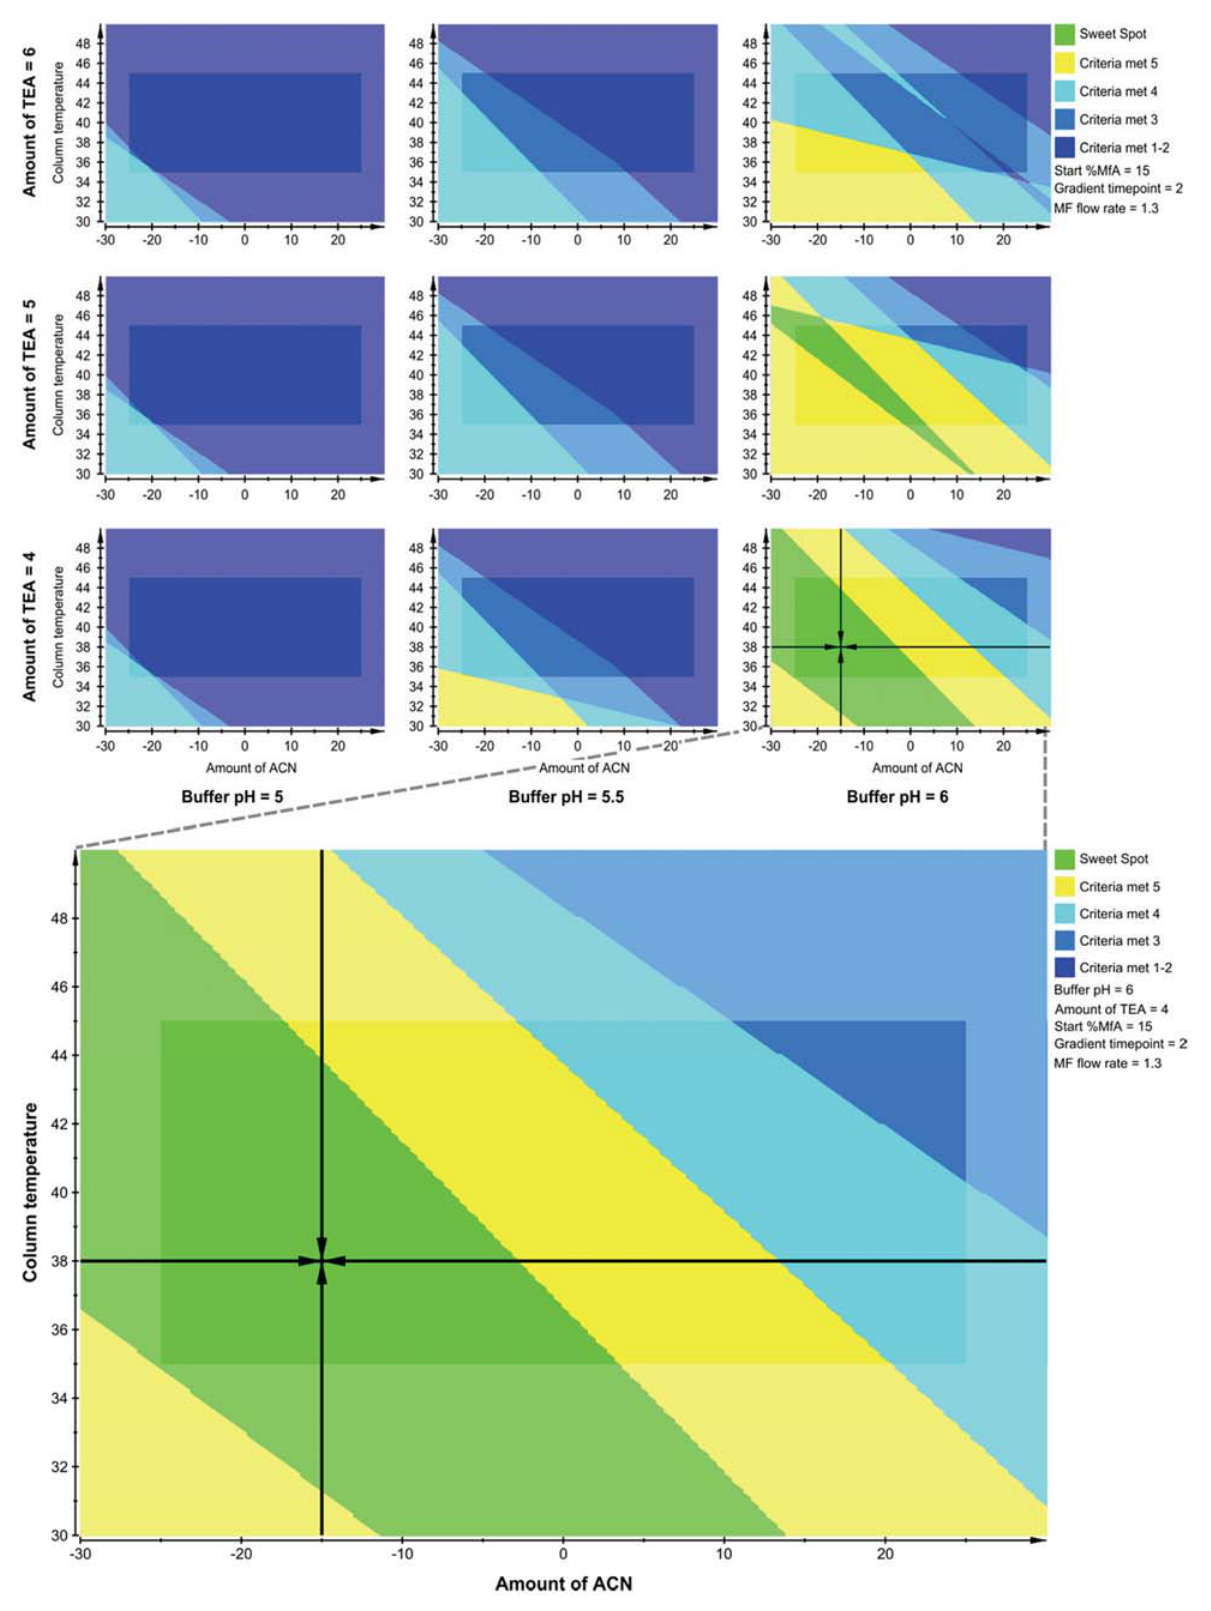
Figure 3. Sweet spot diagram for a PLS model of the analytical operational design region. The optimal chromatographic conditions proposed by MODDE are marked with a